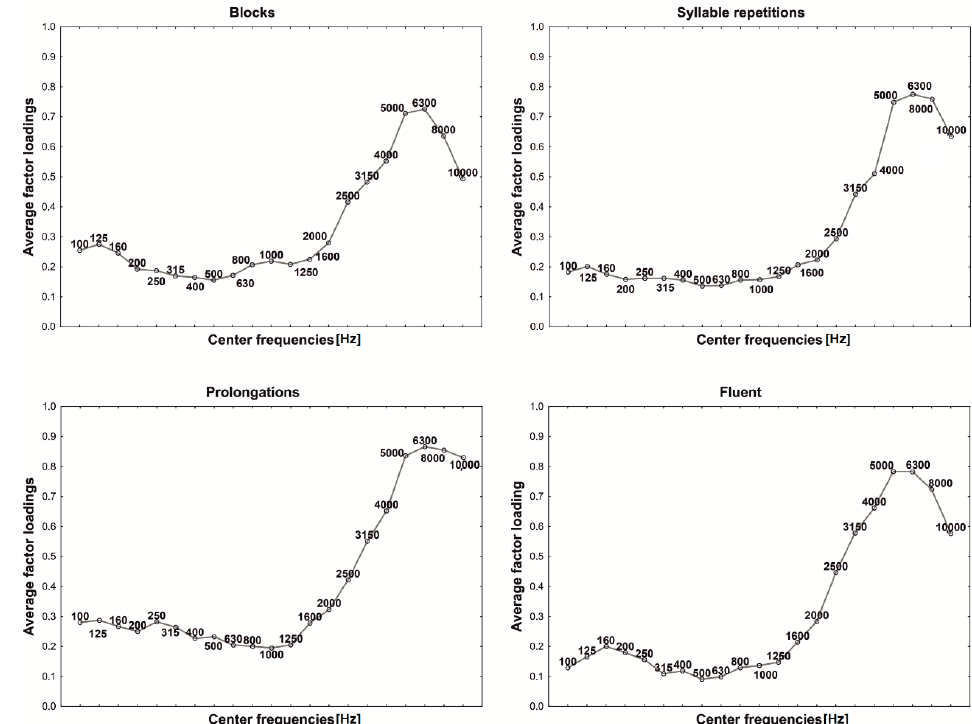
Figure 4. Second component (G 2 ) factor loadings.